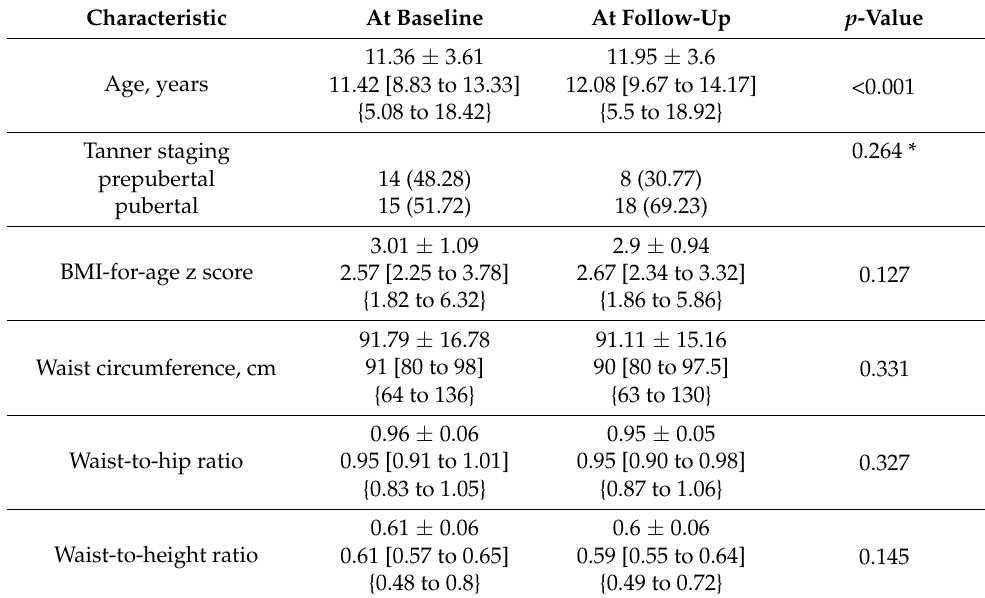
Table 1. Demographic and clinical characteristics of the evaluated children.